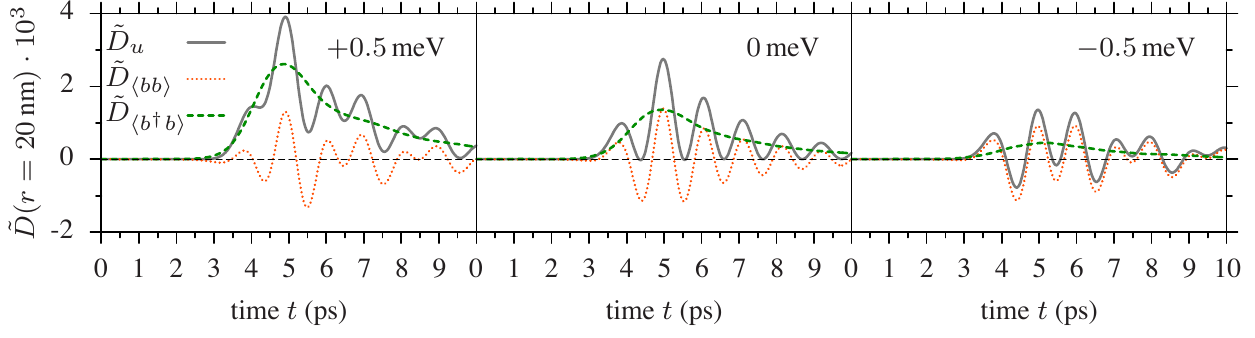
(solid grey), the two-phonon coherence u (dashed green) for (cid:126) δω = 0 meV b † b (cid:104) (cid:105)